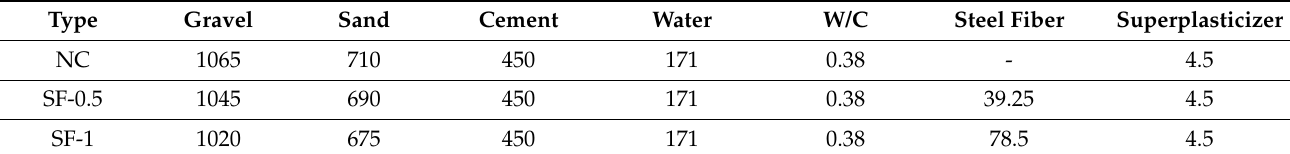
Table 4. Mixing design details (in kg/m 3